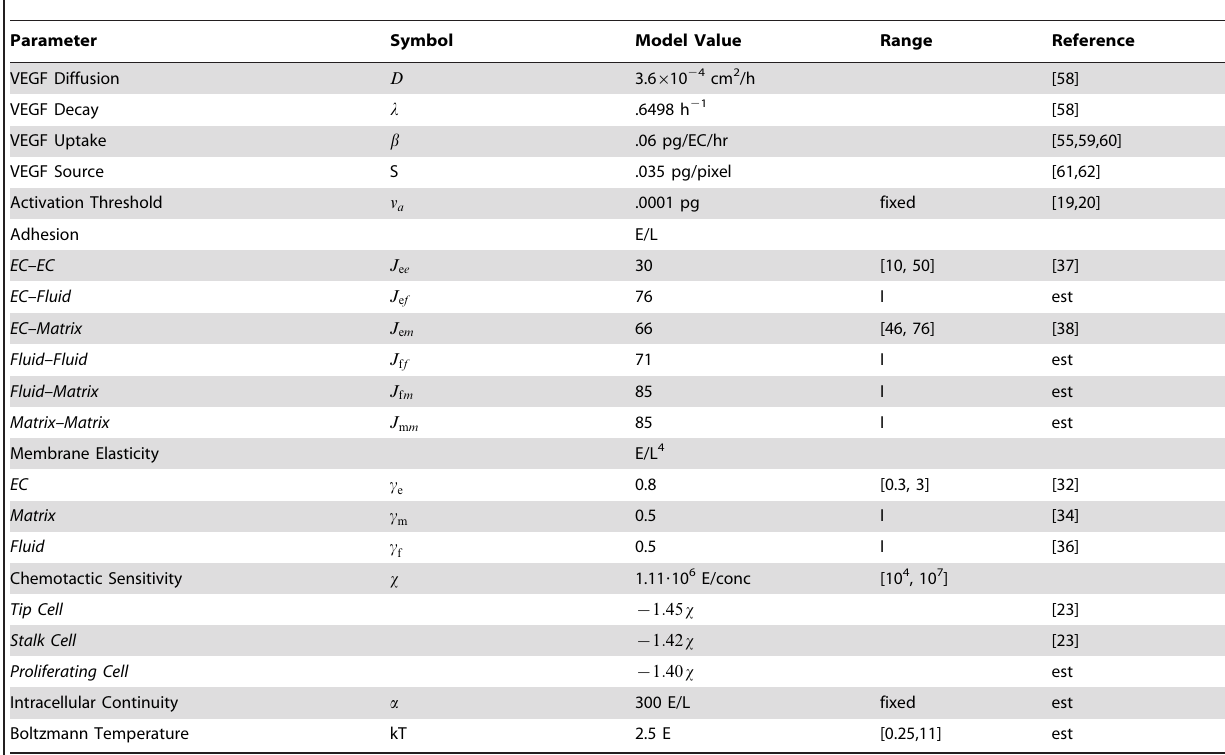
Table 1. Table of parameters, which unless otherwise specified, are used for all